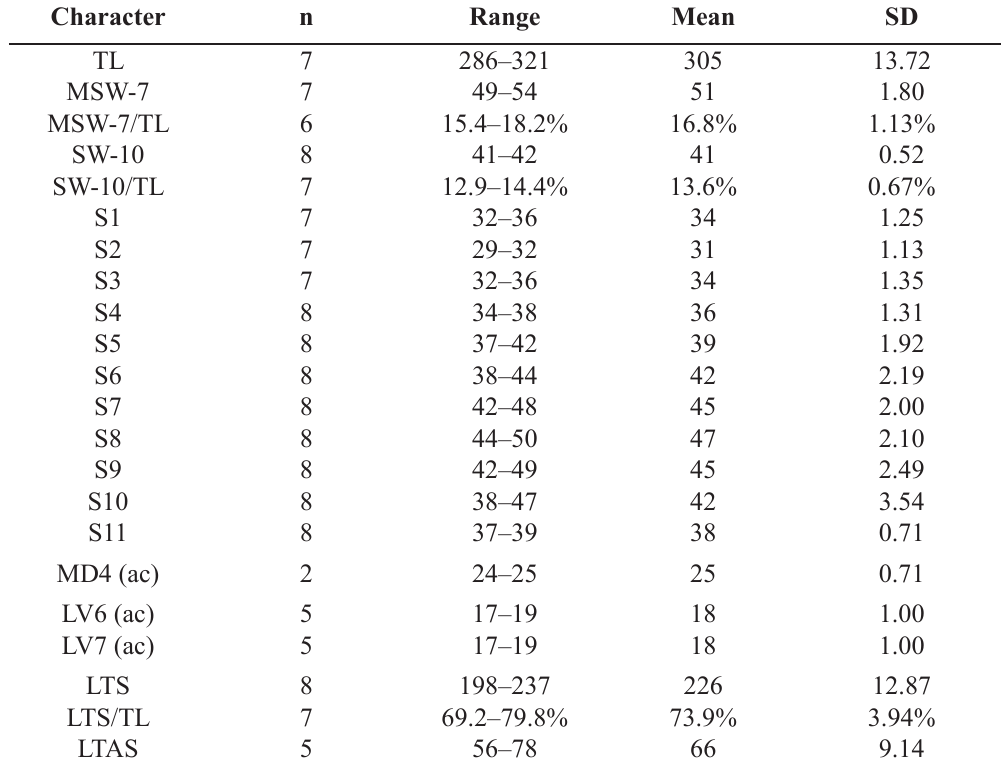
Table 16. Measurements from light microscopy of Echinoderes cf. unispinosus (in µm), including number of measured specimens (n) and standard deviation (SD). Abbreviations: (ac) = acicular spine; LTAS = lateral terminal accessory spine; LTS = lateral terminal spine; LV = lateroventral; MD = middorsal; MSW-7 = maximum sternal width, measured on segment 7 in this species; S = segment lengths; SW-10 = standard width, always measured on segment 10; TL = trunk